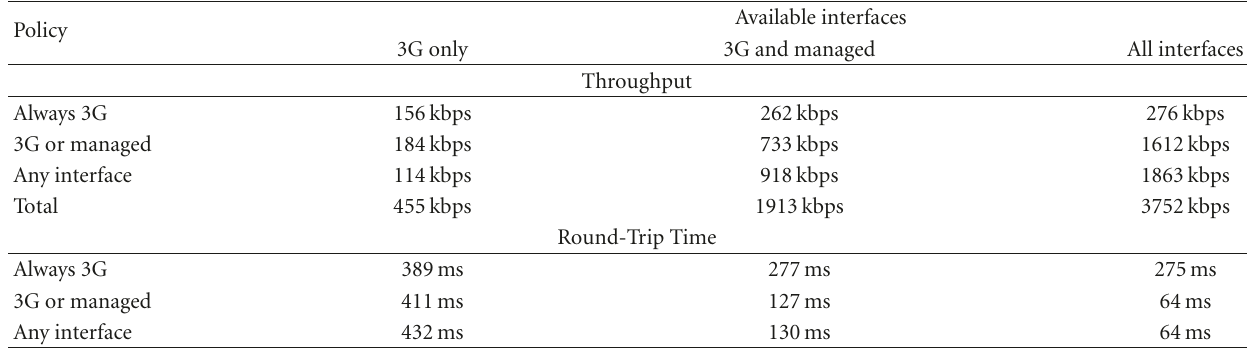
Table 5: Total throughput of three TCP flows and RTT between